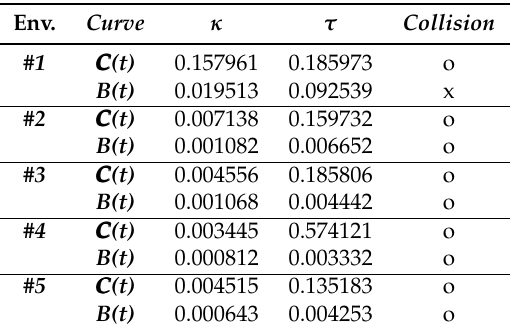
Table 3. Average results of κ and τ along the curves CCC ( t ) and B ( t ) . The column “Collision” indicates collision (x) or no collision (o) of a curve against an obstacle.